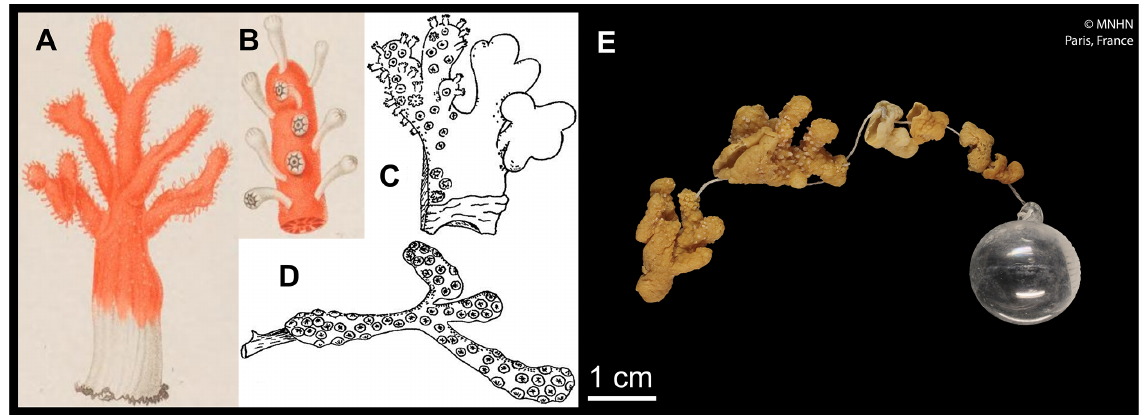
Fig. 11. A–B . Copies of Quoy & Gaimard’s (1833) illustrations of “ A. aurantiacum ”. C–D . Copies of the sketches of upright and encrusting specimens by Benham (1928), identified as A. aurantiacum . E . A. aurantiacum syntype, specimen MNHN-IK-2000-128 (photo by Marie